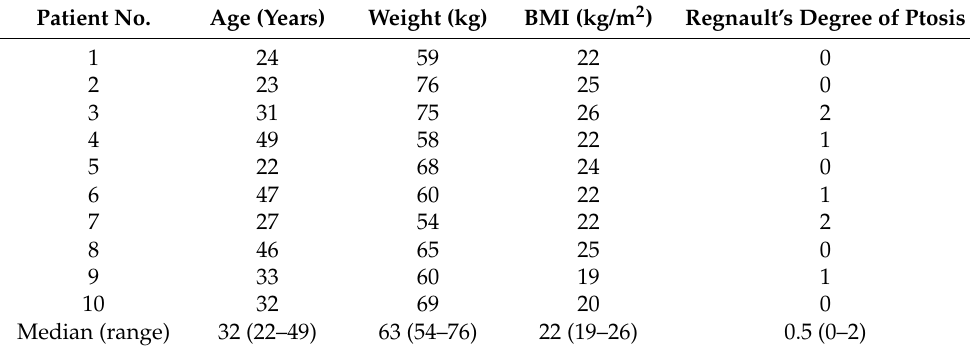
Table 1. Demographics. An overview of age, weight, BMI, and degree of ptosis for each patient of the study is provided. Data are presented as median (range).